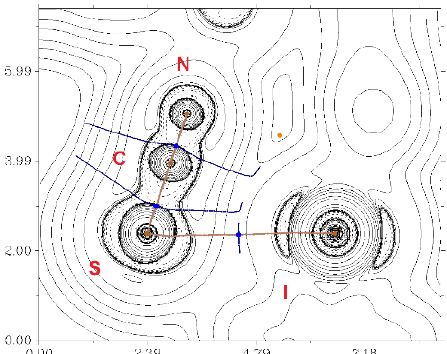
Figure 8. Contour line diagram of the Laplacian of electron density distribution ∇ 2 ρ ( r ), bond paths and selected zero-flux surfaces referring to intermolecular noncovalent interactions I1 ··· S58 in the model